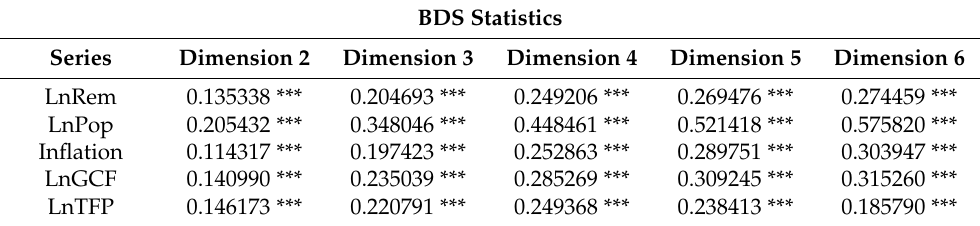
Table A1. BDS Test for non-linearity.